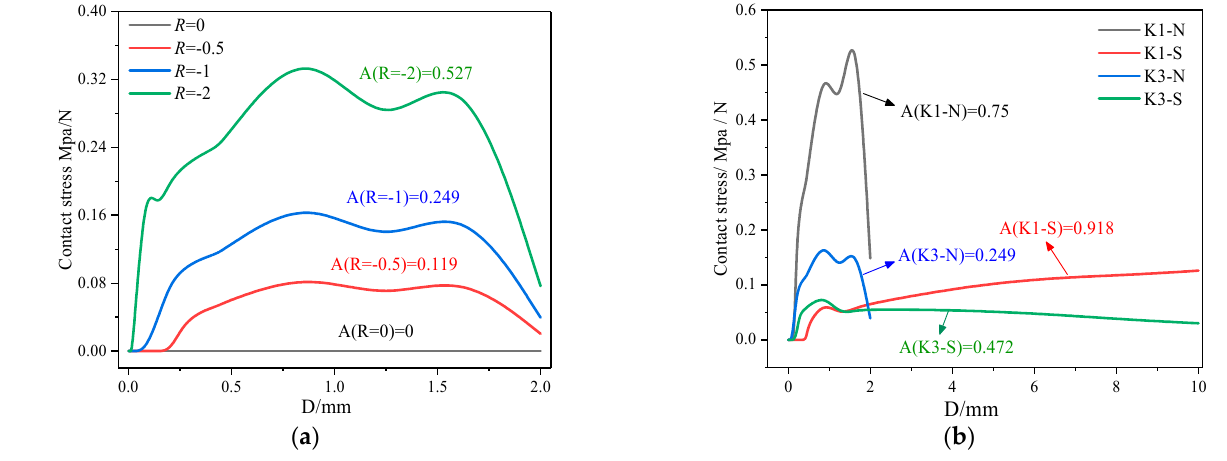
Figure 4. Research of contact stress: ( a ) effect of loading ratio, ( b ) effect of specimen type. 3. Quantification of Constraint, Compressive Loading and Contact Closure.